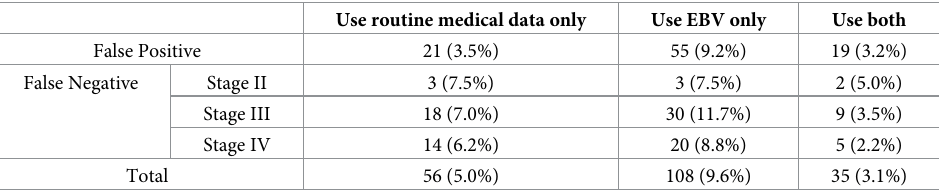
Table 8. Statistics of misclassified